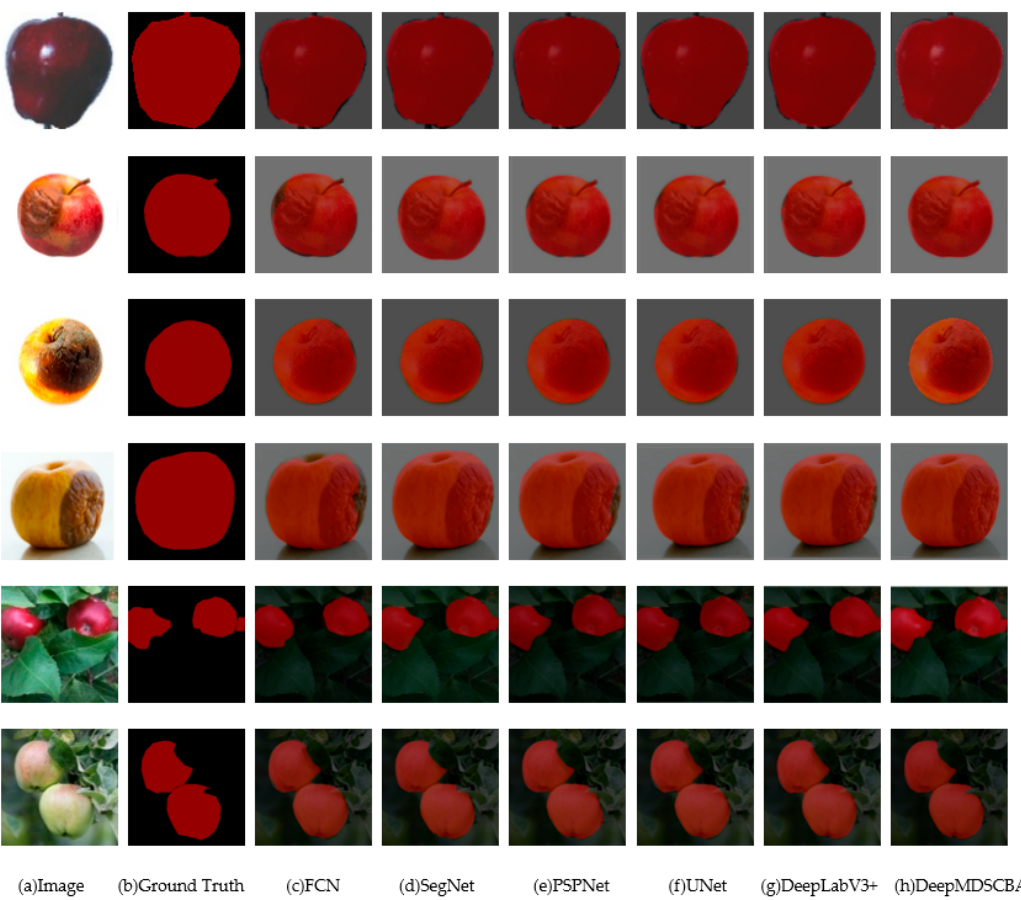
Figure 8. Results of segmentation using different algorithms.